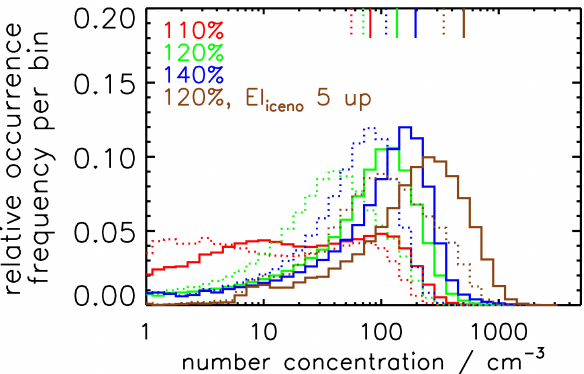
Figure 14. Relative occurrence frequencies of ice crystal number concentrations for various RH i and an elevated EI iceno (see legend). The according mean values are indicated by the vertical bars. Con- trail age is 3min (solid) or 5min (dotted). The bin sizes increase